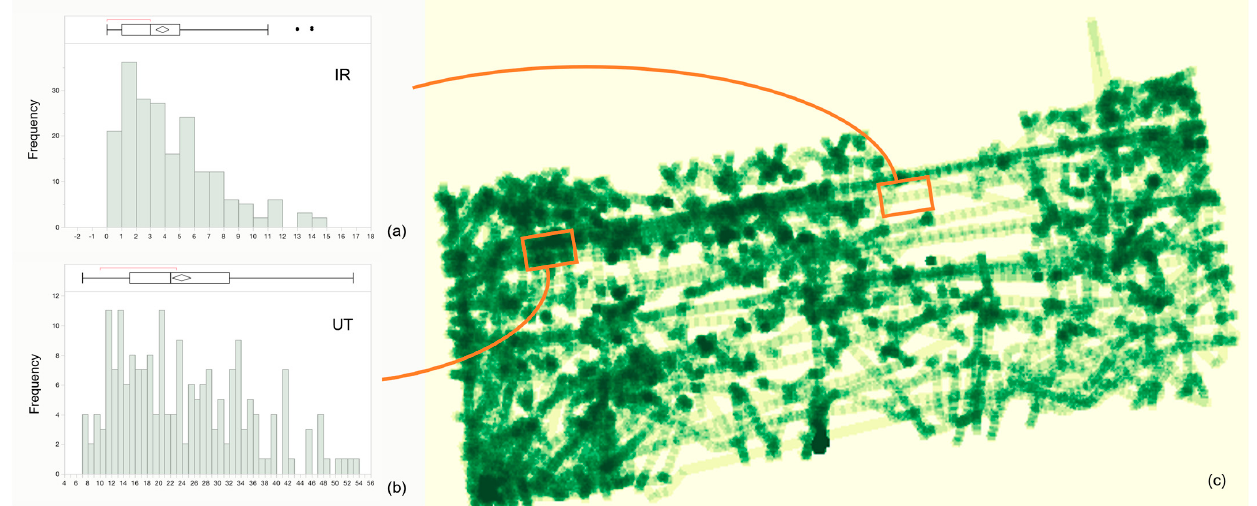
Figure 2. Number of passages distributions on vineyards positions. ( a ) Number of passages distri- bution on the inter-rows area. ( b ) Number of passages distribution under vineyard trellis. ( c ) An example of trampling distribution on the whole experimental area managed by autonomous mowers.